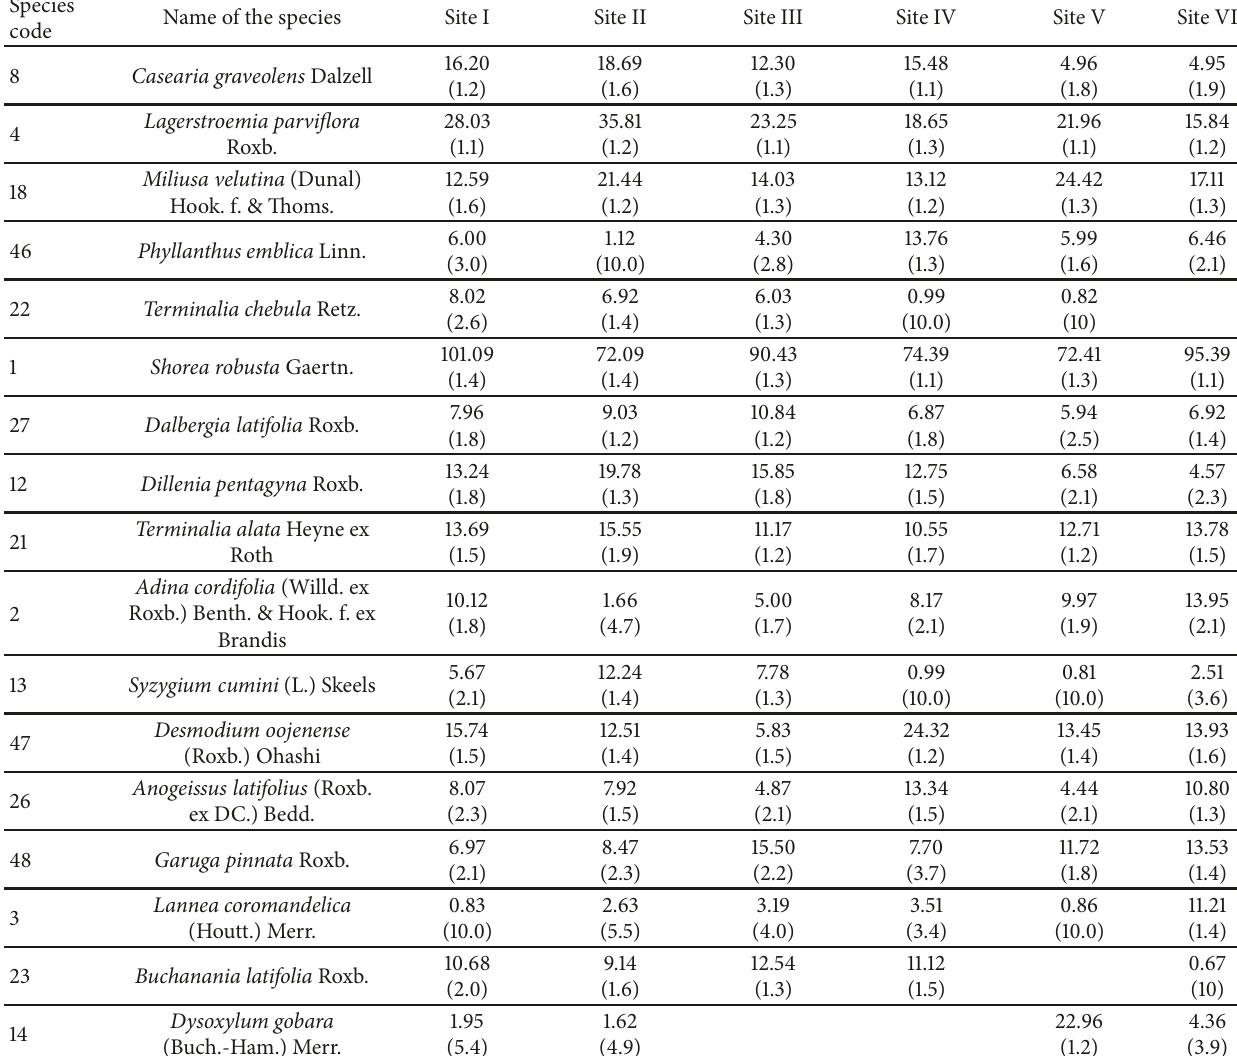
Table 14: IVI of predominant species and Morisita Index of Dispersion in Parsa Wildlife Reserve. Species